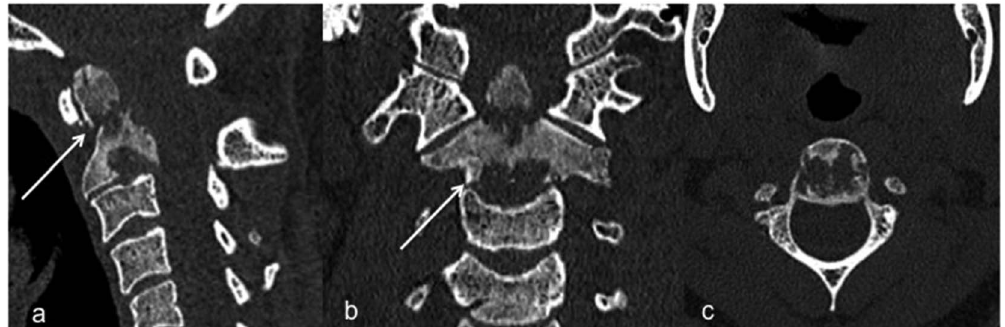
Figure 1. (a) Sagittal, (b) coronal and (c) axial CT-scan reformations of the upper cervical spine in a 30-year-old woman, showing the mixed appearance of the C2 vertebral body with a ground-glass appearance and osteolytic areas in the base of the odontoid process with a pathologic fracture (thin arrow) and in the inferior part of the vertebral body with partial destruction of the inferior endplate (thick